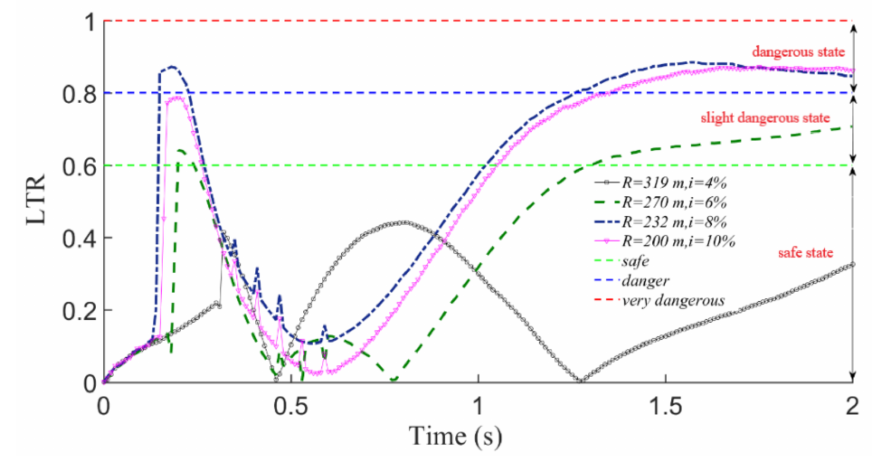
Figure 10. Simulation results of LTR at 80 k m/h before collision.